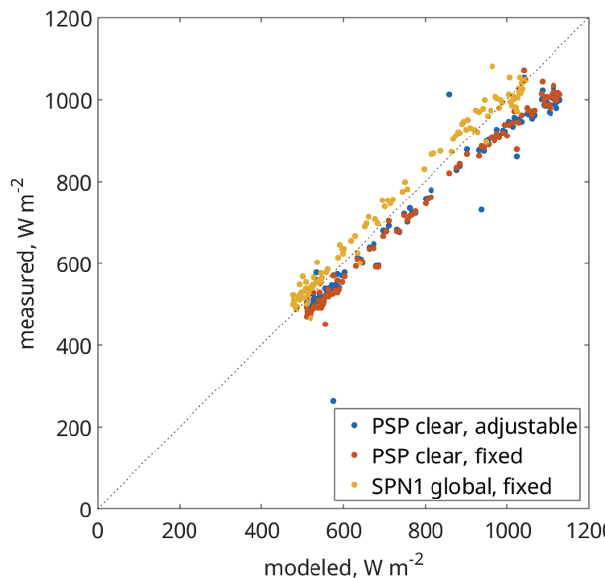
Figure 2. Measured vs. modeled irradiance at CUES for three broadband sensors: an Eppley precision spectral pyranometer (PSP) mounted on an adjustable albedometer arm kept ∼ 1m above the snow surface (PSP clear, adjustable), a PSP mounted ∼ 8m above bare ground (PSP clear, fixed), and a Delta-K SPN1 Sunshine pyra- nometer also mounted ∼ 8m above bare ground (SPN1 global, fixed). The differences between the instruments, particularly at high radiation values, are likely caused by different thermal responses (Haeffelin et al.,